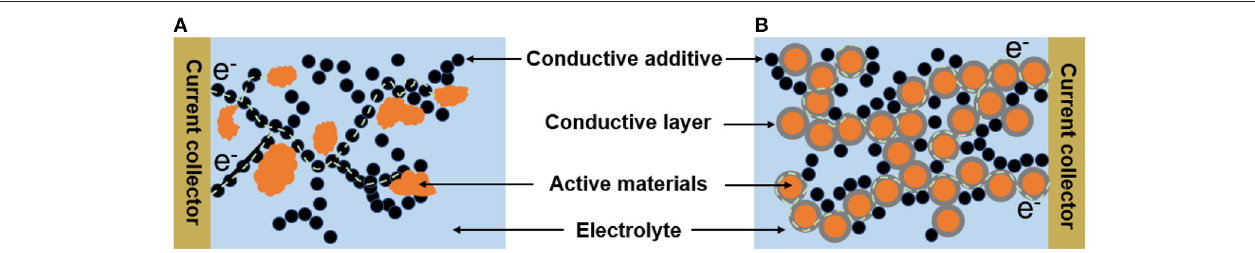
FIGURE 1 | Schematic diagrams for different microstructures of the suspension electrode (A) “point-to-point;” (B) “face-to-face” contact mode between the active materials and conductive